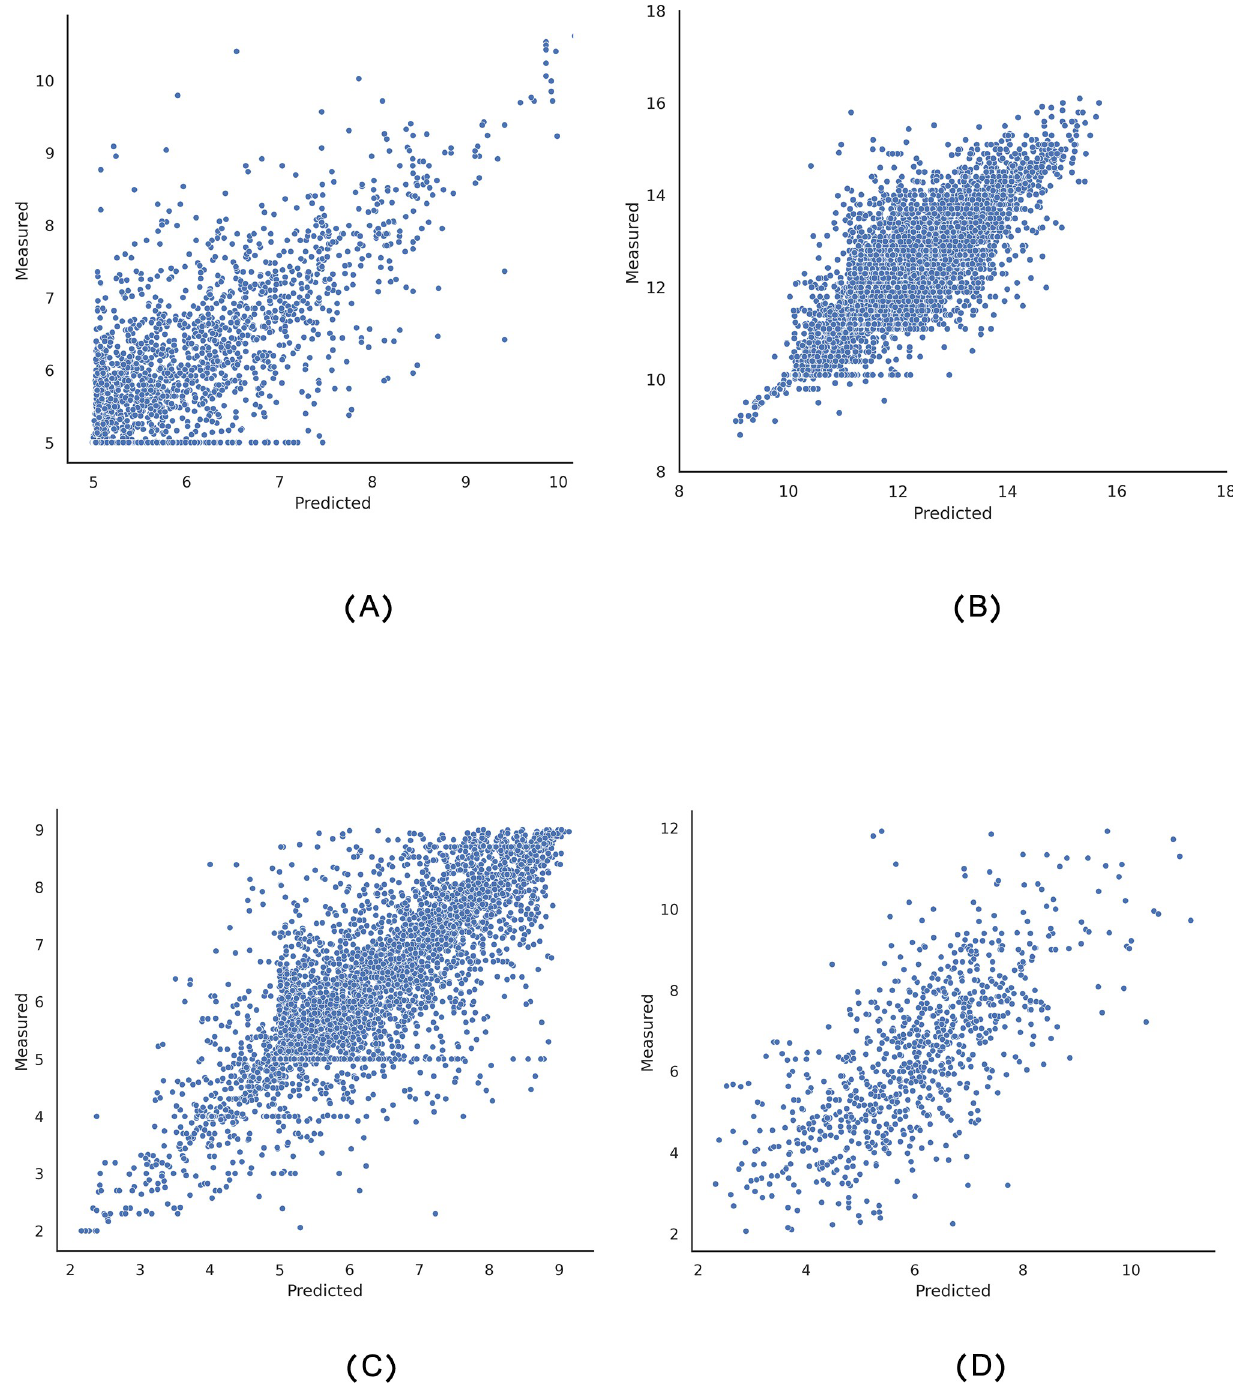
Fig 2. Predicted and actual binding affinities for the (A) Davis, (B) Kiba, (C) BindingDB, and (D) PDBbind datasets. https://doi.org/10.1371/journal.pcbi.1011036.g002 Fig 3 represents the distribution of CI values for DeepDTA-Sim, DeepDTA-CNN, GraphDTA, FusionDTA, and BiComp-DTA for the refined Davis dataset experiment. The rel- evant adjusted p-values with Bonferroni corrections for BiComp-DTA, against alternative